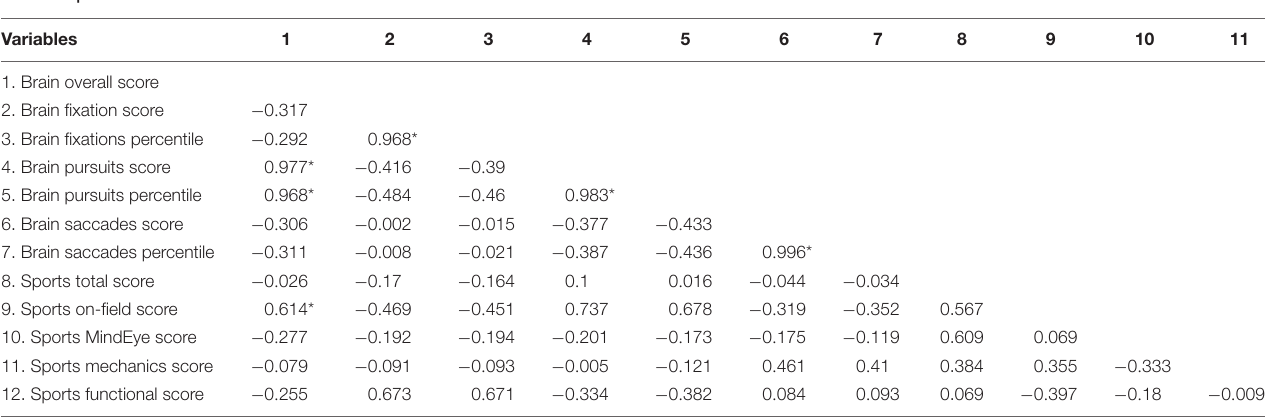
TABLE 7 | Correlation statistic between variables for